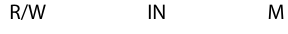
Table 1 The truth table for the developed memory unit